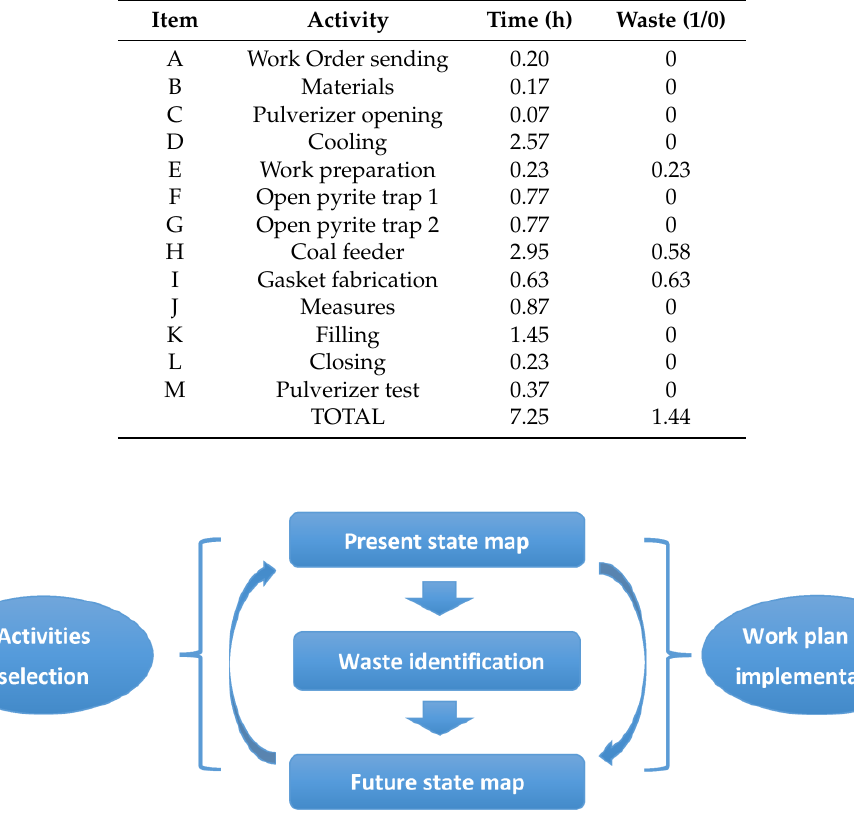
Figure 8. Procedure for performing the value stream mapping.